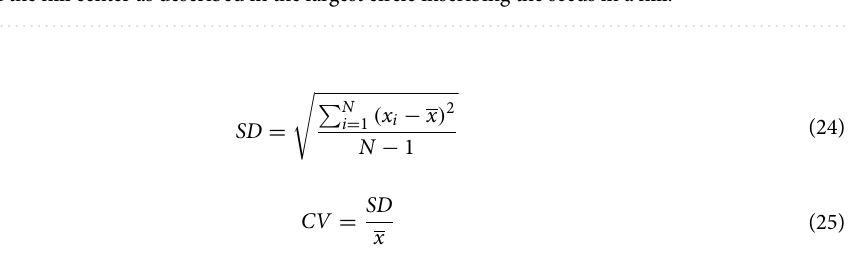
Figure 7. Schematic diagram of seeds sowed showing the position of each seed relative to the first seed dropped ( X